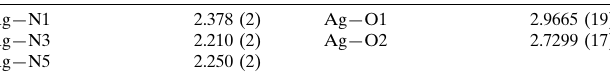
Selected bond lengths (A˚